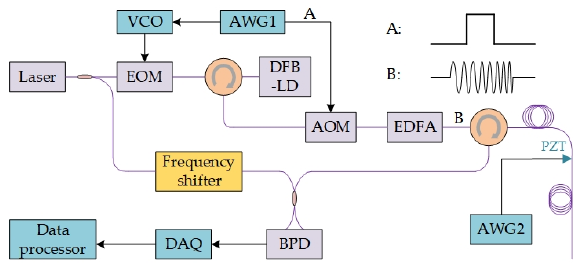
Figure 13. Experimental setup. Reproduced with permission from our previous paper [22], published by Optical Society of America, 2017.